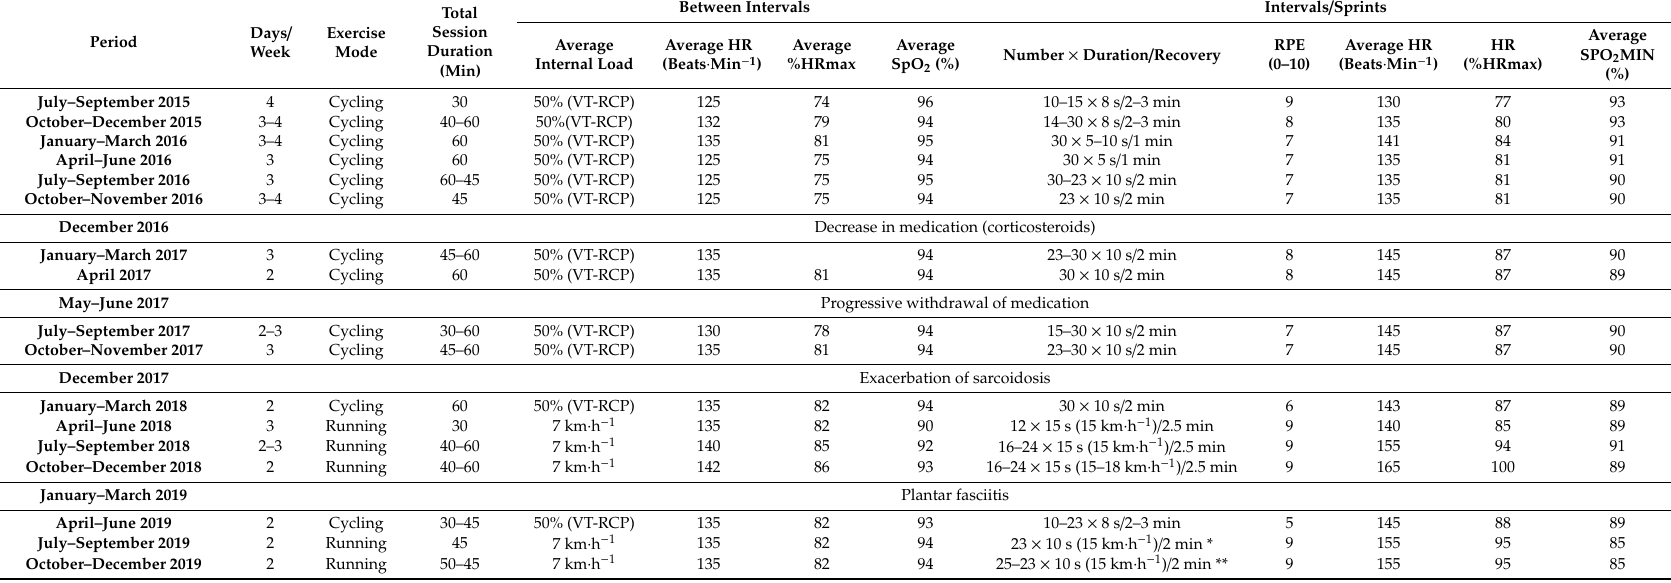
Table 1. High-intensity interval training